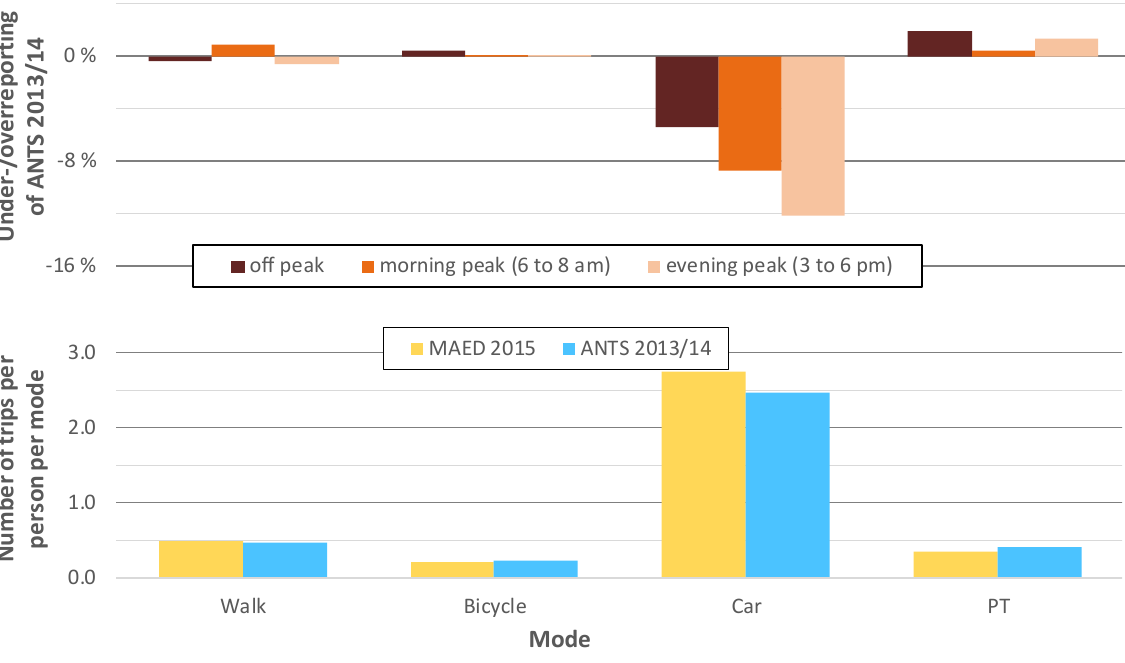
Figure 6. Distribution of modes of all trips per person per day (below) and respective under-/overreporting of ANTS 2013/14 (above).